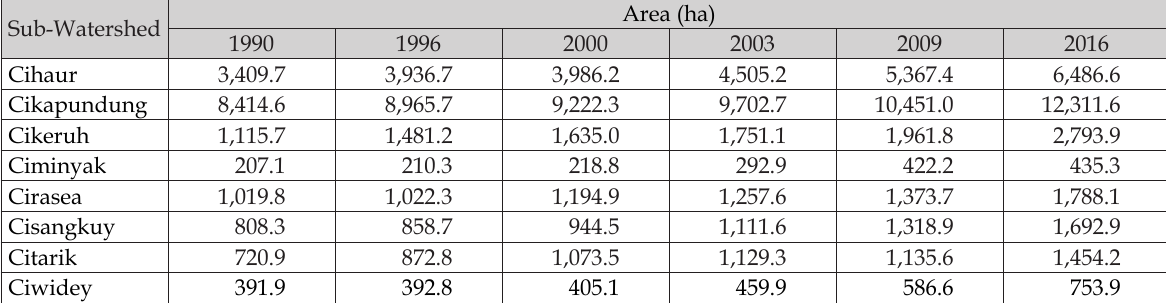
Table 2. Urban/built-up area size in the eight sub-watersheds in the study area.